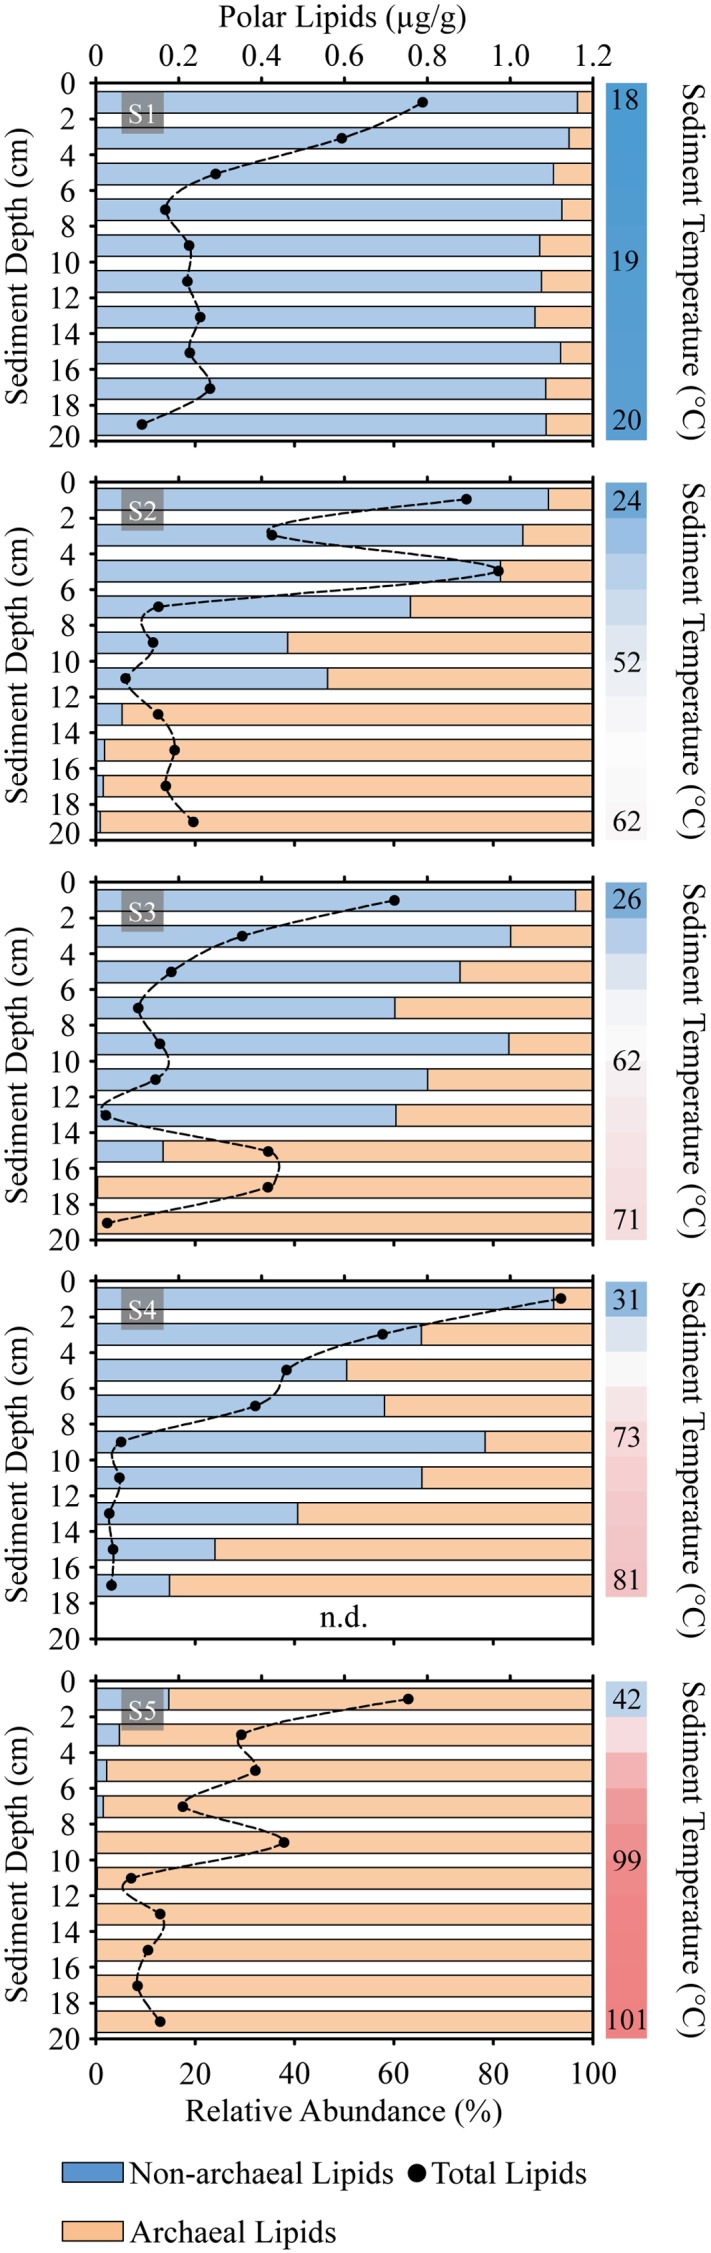
Sediment profiles of concentration of total microbial polar lipids (dots) and distribution of archaeal vs. non-archaeal lipids (horizontal bars) in Spathi Bay. Samples were analyzed in 2 cm horizons from surface until 20 cm of sediment depth. Adjacent vertical bars indicate the thermal gradient of each station with upper, mid and bottom sediments temperatures in °C. n.d., no data.